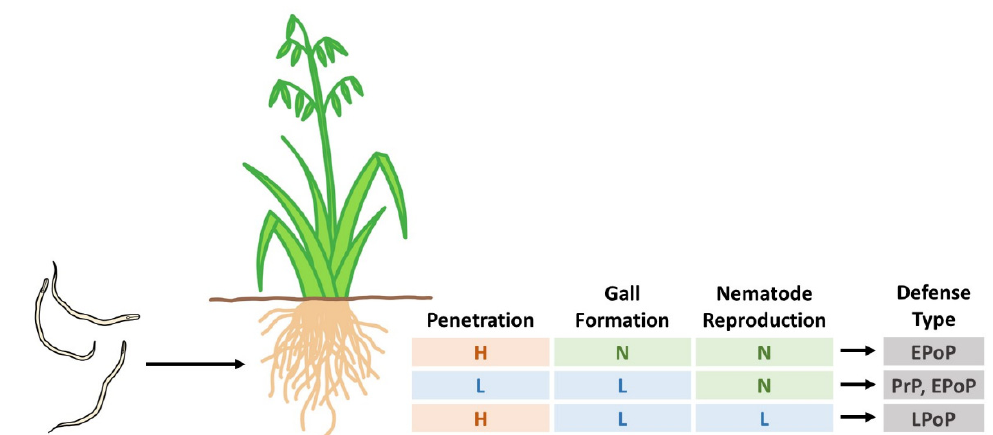
Figure 3. Overview of different defenses of oats against root ‐ knot nematodes observed in this study. H = high; L = low; N = (almost) not observed; EPoP = early post ‐ penetration; PrP = pre ‐ penetration; LPoP = late post ‐ penetration.